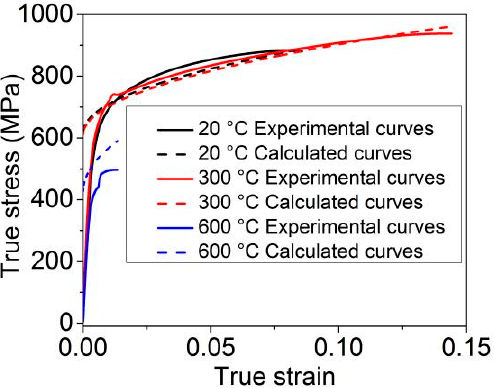
Figure 11. Calculated stress-strain curves based on Ashby work hardening theory and experimental curves.